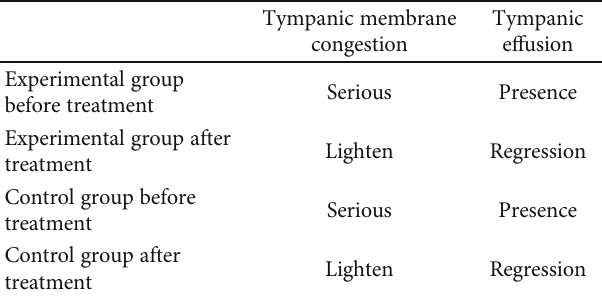
Table 4: Tympanic membrane morphology changers.